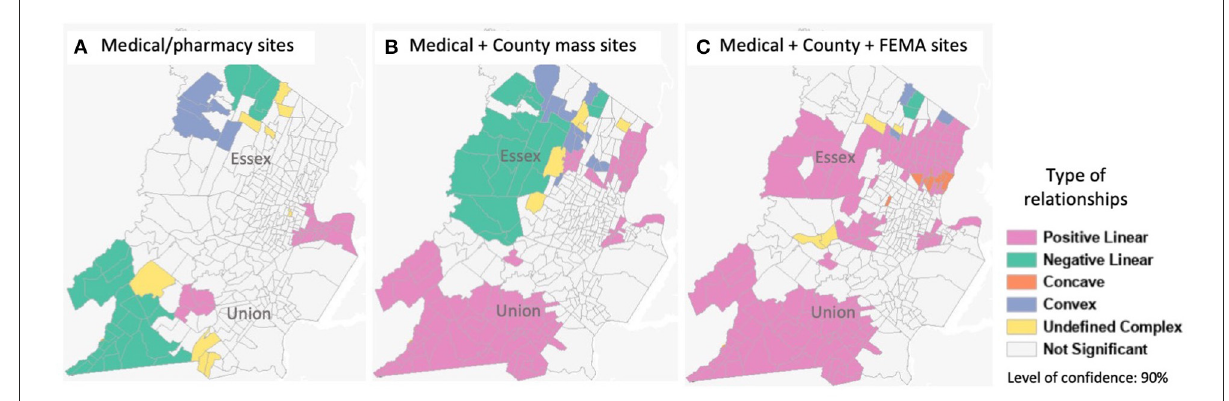
FIGURE3 Bivariate relationship analysis between the percentage of minority population and accessibility. (A) Medical/pharmacy sites. (B) Medical + County mass sites. (C) Medical + County + FEMA